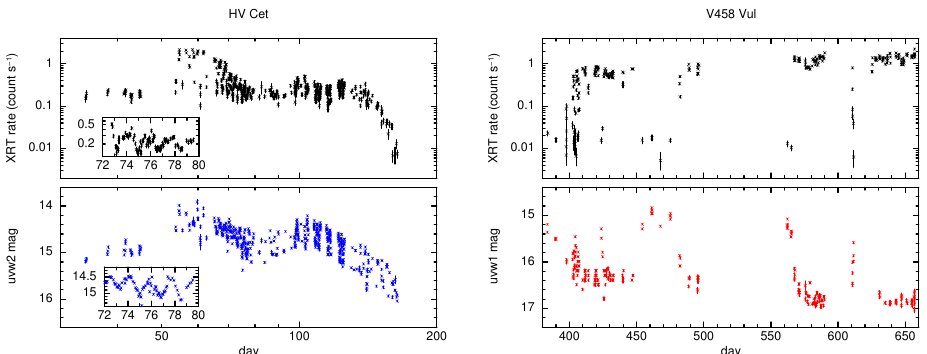
Figure 1. Examples of light-curves where the UV emission is not simply a series of power-law decays. Left : HV Cet. This nova shows a strong periodic oscillation in both the UV and X-ray bands, as well as an underlying slower modulation. The inset shows a zoom-in of the 1.77-d period, plotted in linear time. Right : V458 Vul. This nova shows aperiodic UV modulation, which is approximately anti-correlated with the corresponding X-ray emission. In both cases, the XRT count rate is over 0.3–10 keV. Table 1. Names, eruption details, orbital periods, interstellar reddening E(B − V), and distances of the novae in this paper, ordered by eruption date; symbiotic systems are marked in the sixth column. The novae marked in bold are recurrent; the eruption date given is that for the data included in this